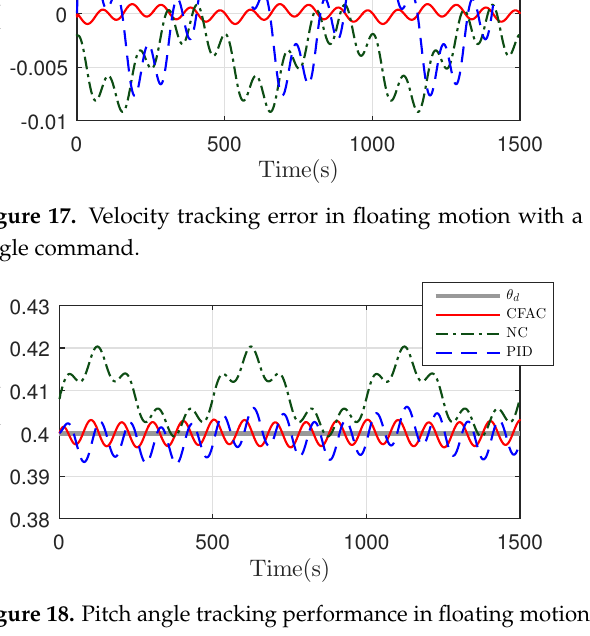
Figure 18. Pitch angle tracking performance in floating motion with a variable velocity and constant pitch angle command.